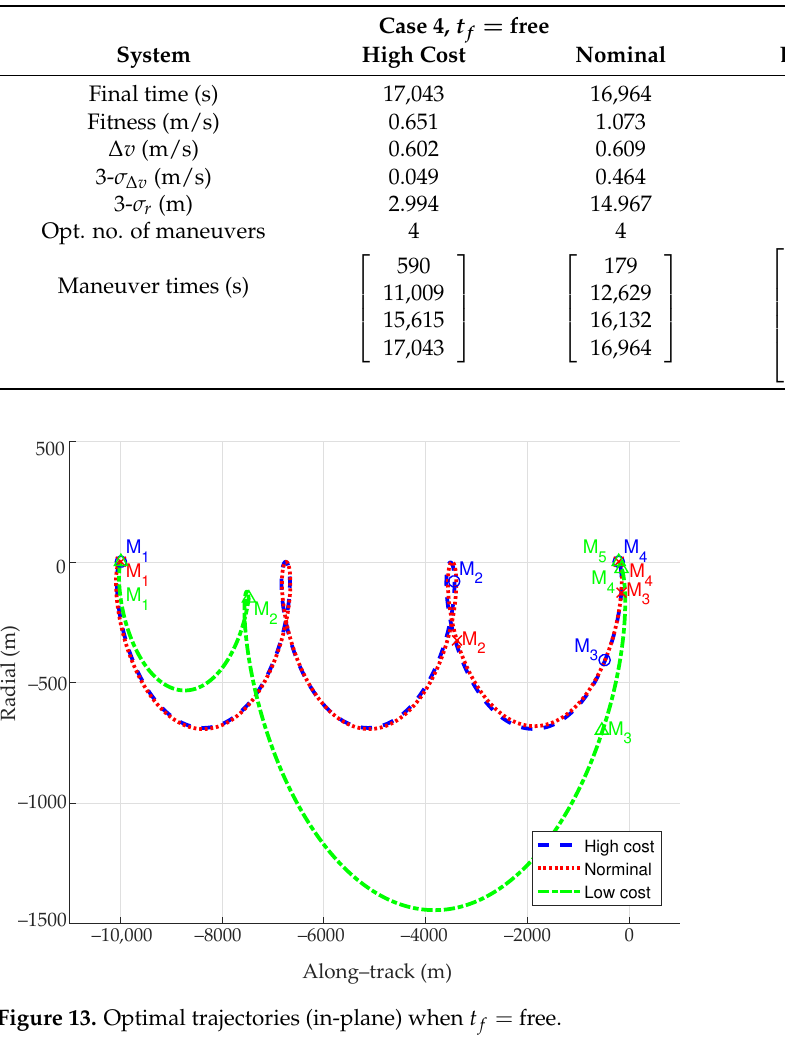
Table 6. Stochastic optimal performance results, t f = free.